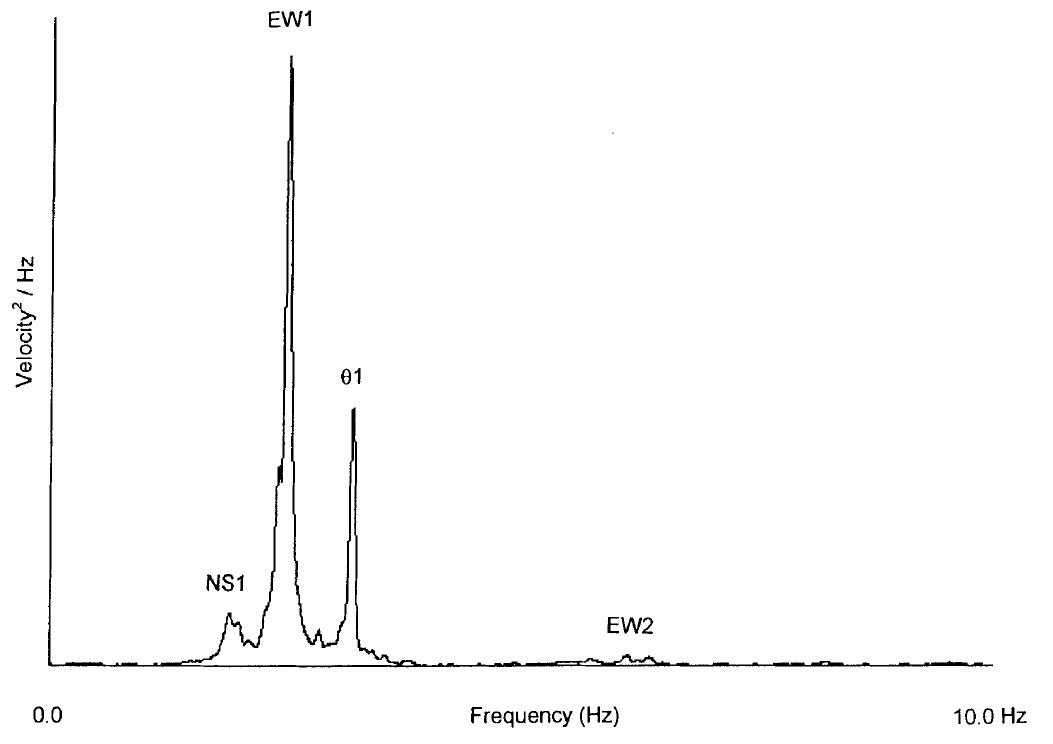
Fig. 2. An autospectrum measured for the Timber Frame